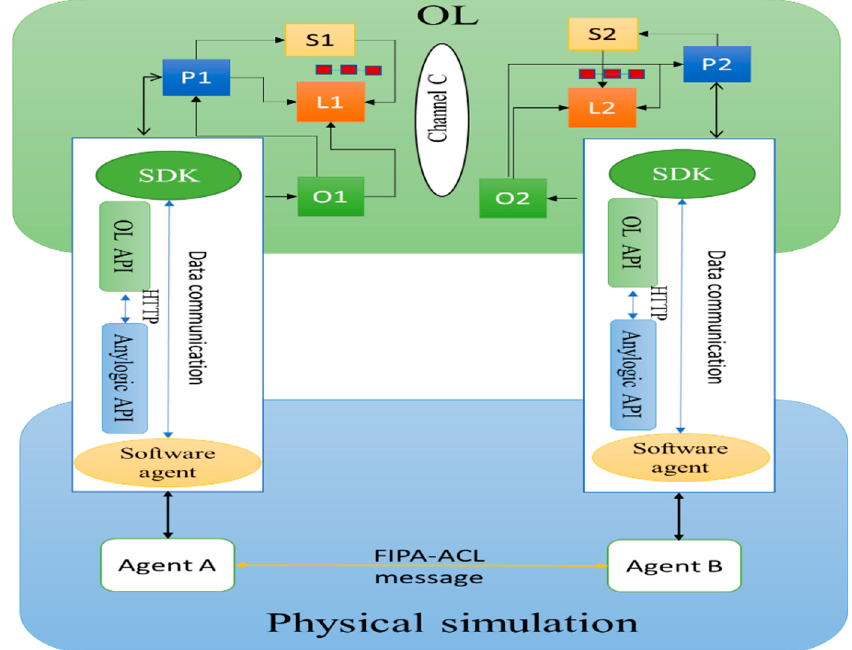
Figure 8. Communication between physical simulation module and OL .